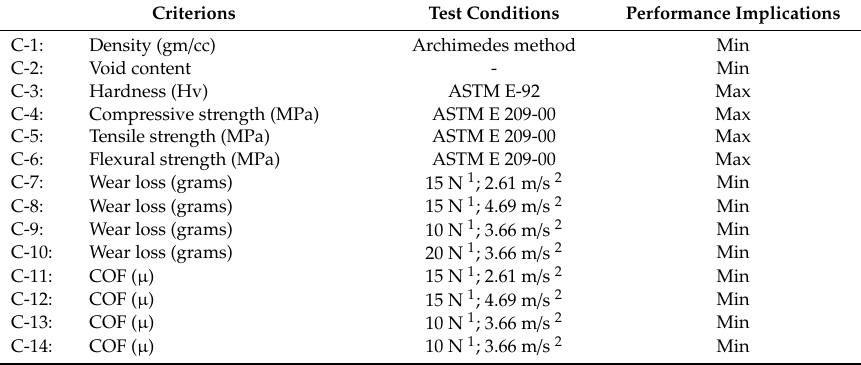
Table 2. Details from the selected criteria